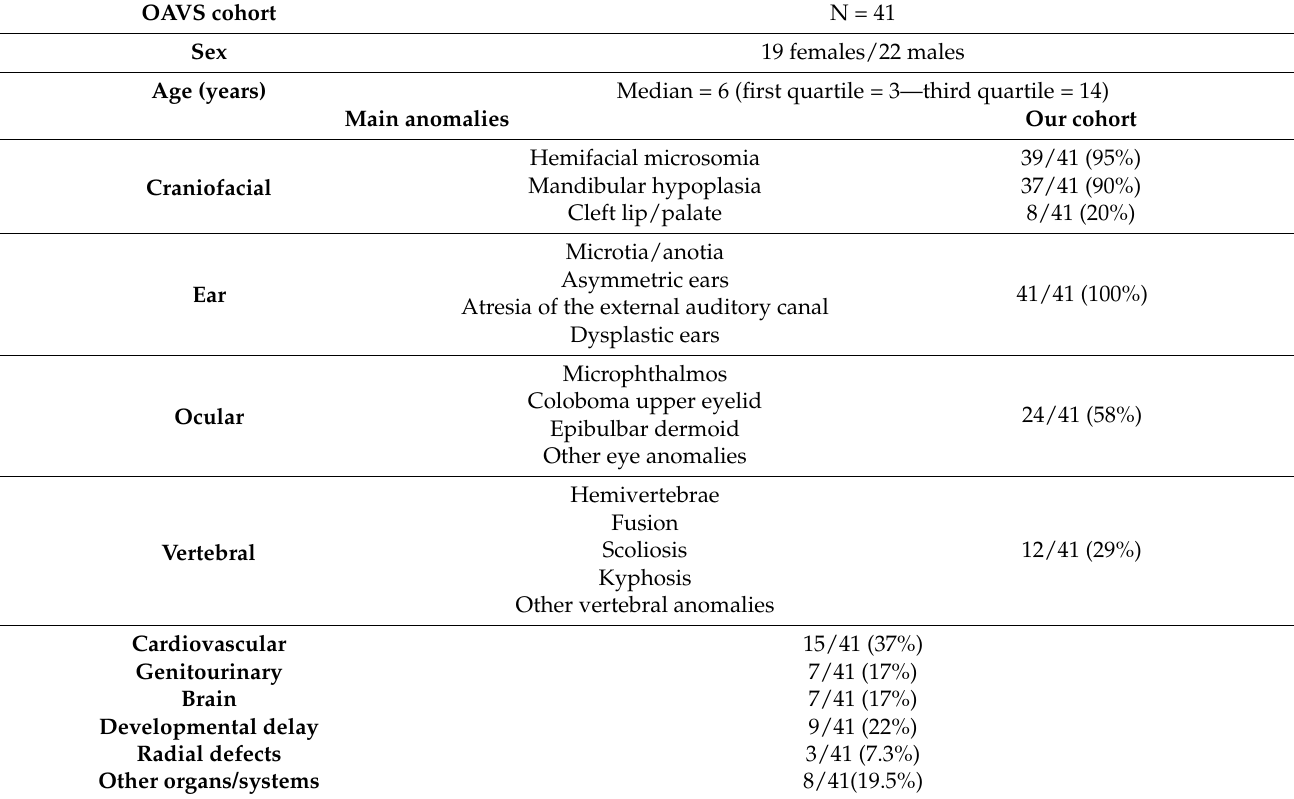
Table 1. Summary of the main clinical features of the 41 OAVS